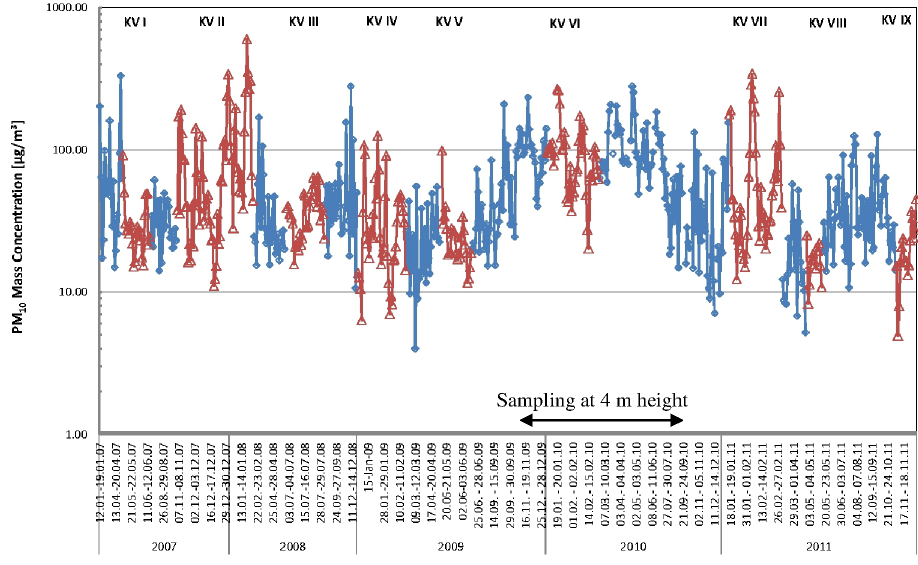
Fig. 2. Time series of PM 10 mass concentration at CVAO from January 2007 to November 2011. Red lines with open triangles represent periods of intensive field measurements (9 in total labeled KV I to KV